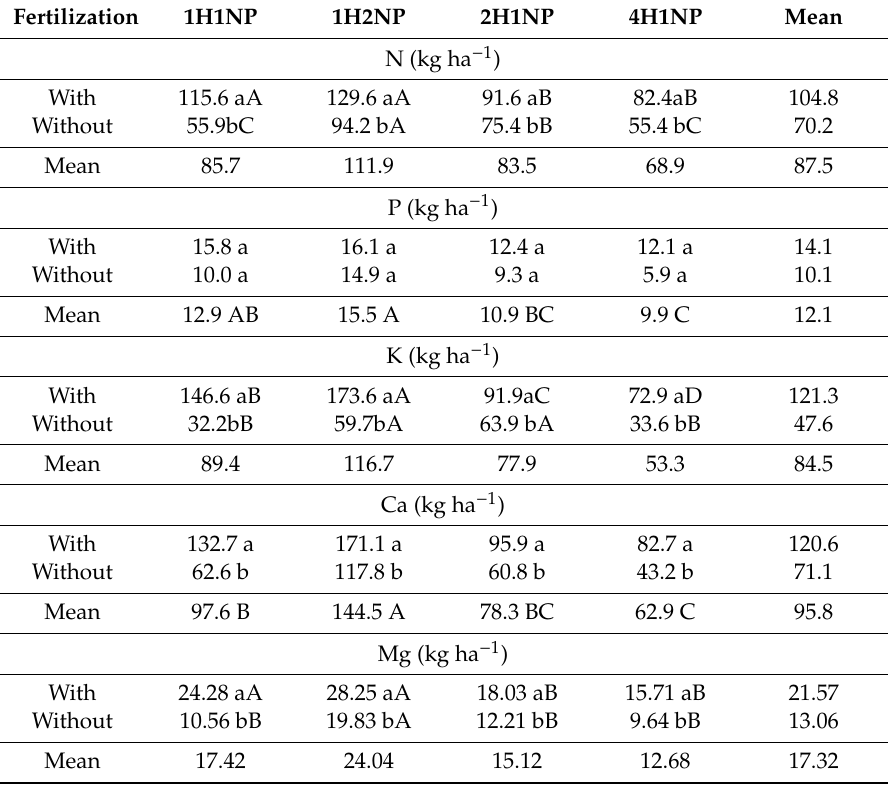
Table 4. Amounts of N, P, K, Ca and Mg in the trunk of the clone GG157, at 60 months of age, in response to liming / fertilization (With or Without) and height (H) and number (NP) of poles per stump at the time of pole selection.